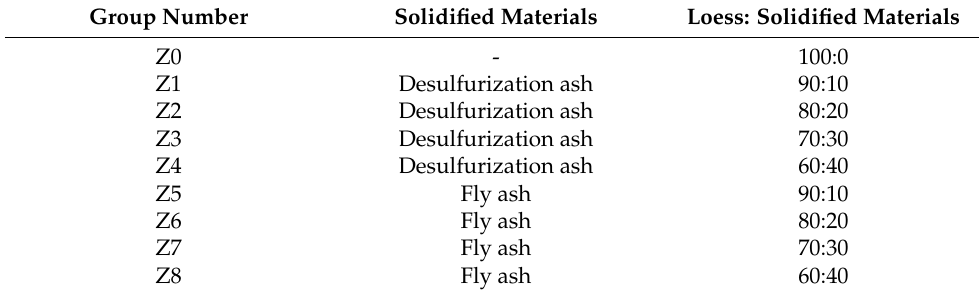
Table 4. Compaction test scheme.